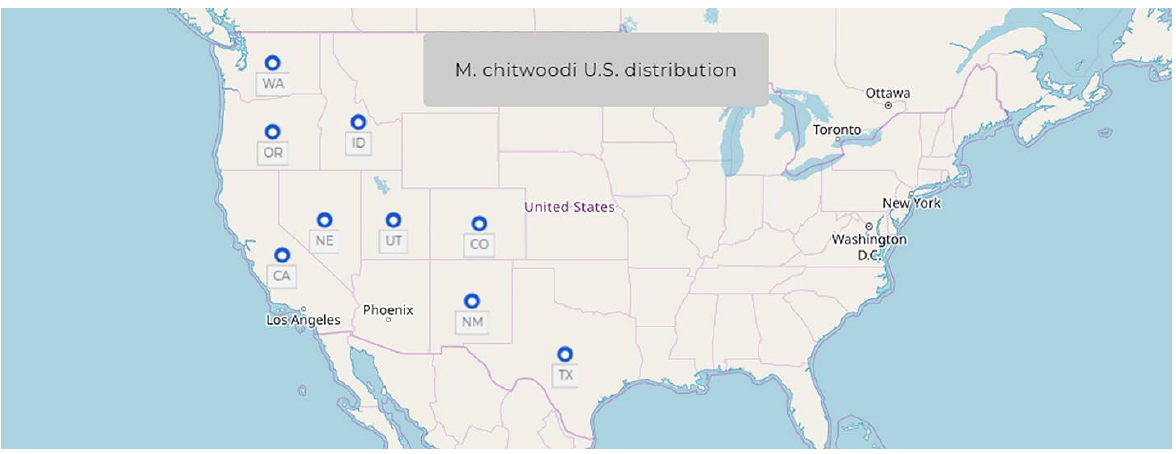
Figure 7. Continental U.S. distribution map of Meloidogyne chitwoodi (adapted from CABI-ISC) [26].